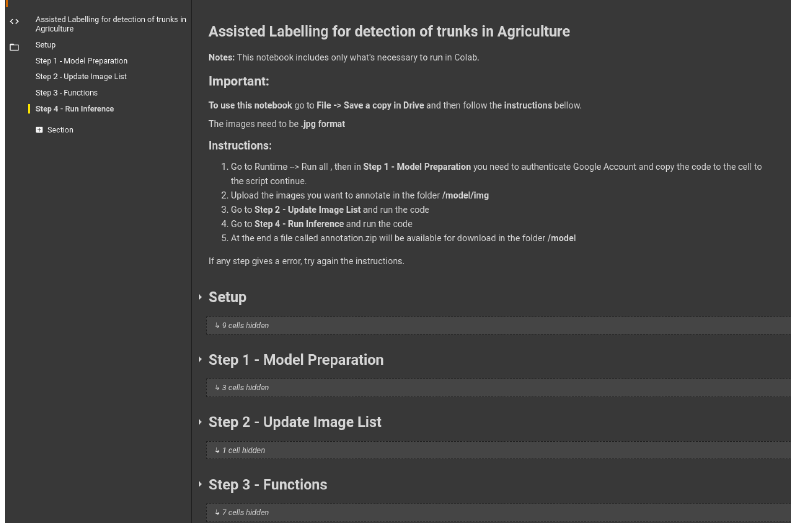
Figure 8. The assisted labelling tool